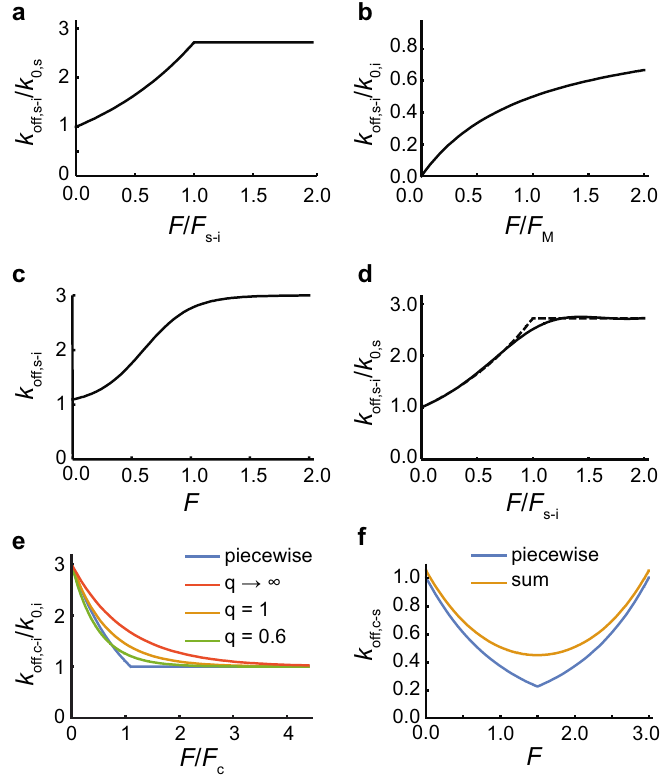
Figure 2. Analytical models for the force-dependent unbinding constant of slip-ideal, catch-ideal, and catch-slip bonds. ( a ) The piecewise function that explicitly models a slip-ideal bond (Eq. (10)) normalized by the unbinding constant at zero force and plotted as a function of force normalized by the slip-ideal transition force for the case of F s-i = F s . ( b ) A Michaelis–Menten or Langmuir absorption-like approximation of the slip-ideal bond (equation (S1)) normalized by the ideal bond’s unbinding constant and plotted as a function of the force normalized by the Michaelis constant-like characteristic force. ( c ) A sigmoidal approximation of a slip-ideal bond (equation (S3)) where k a = 2 , k b = 1 , F a = 1 5 and F b = 3 5 . ( d ) A rational interpolation approximation (equation (S5), solid line ) of the piecewise function from panel ( a ) ( dashed line ) for a slip-ideal bond with F s-i = F s = 1 , which is equivalent to β = 1 (Supplementary information), normalized by the slip-bond unbinding constant, and plotted as a function of the force normalized by the characteristic force of the slip ideal k off,s-i ( F ( t )) = transition, i.e., k 0,s Eq. (13)) that explicitly models a catch-ideal bond, as well as functional approximations of that function ( red , yellow , green , Eq. (20)), normalized by the characteristic slip-bond unbinding constant and plotted as a function of force normalized by the force of the catch-bond for the representative case of k 0,c = 3 k 0,i . ( f ) The piecewise function ( blue , Eq. (16)) and sum formulation ( yellow , Eq. (17)) of a model for the force-dependent unbinding constant of the catch-slip bond. In both cases, we used k 0,c = 1 s −1 , F c = 1 pN, k 0,s = 0.05 s −1 , and F s = 1 pN as an example set of parameters. Given these parameters, F c-s = 1.50